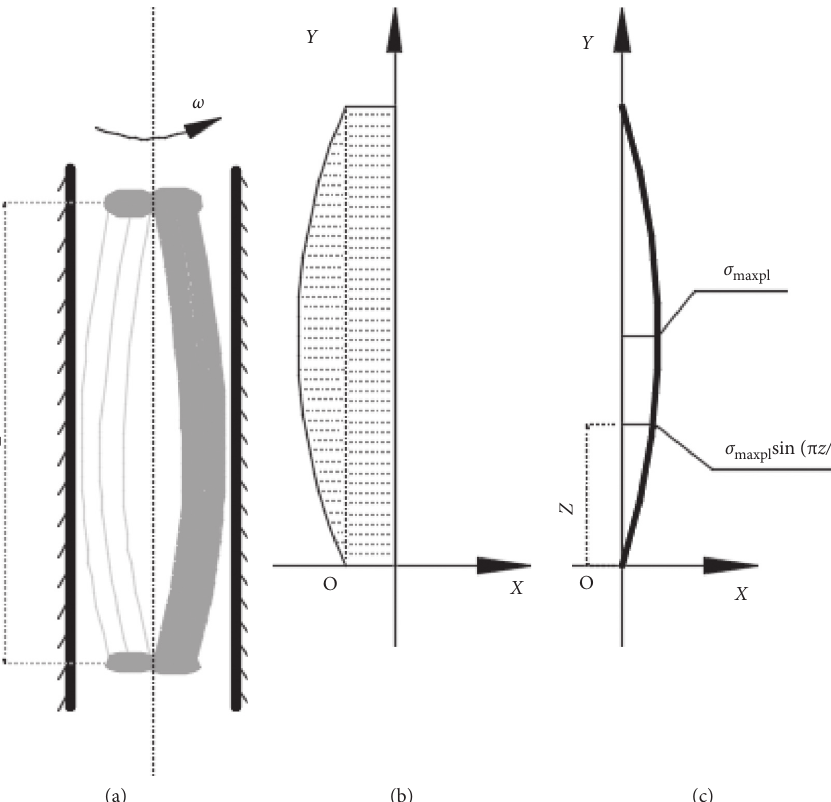
Figure 2: (a) Schematic diagram of drillstring whirl. (b) Schematic diagram of stress distribution. (c) Schematic diagram of